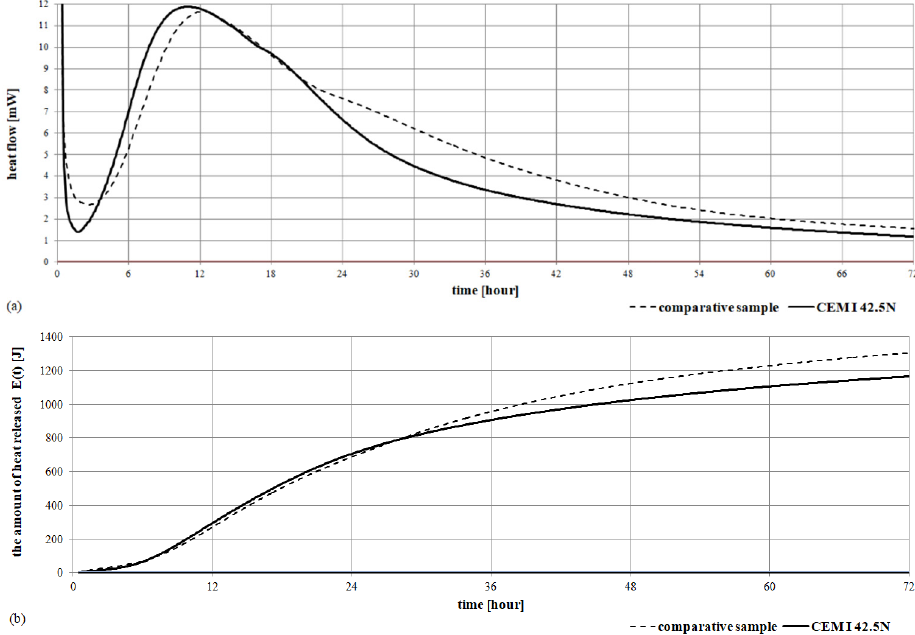
Figure 3. Cement characteristics: ( a ) isothermal calorimetry, ( b ) total heat evolution curves, and ( c ) cement diffraction pattern. 3.2. Materials: Ceramic Dust Ceramic dust included crystalline components: quartz, mullite, cristobalite, corundum, very small amounts of clay minerals, and anorthite. [81] The characteristics of the ceramic dust are presented in Figure 4. Figure 4. The ceramic dust intended for the laboratory tests: ( a ) natural sample, ( b , c ) sample observed in SEM, ( d ) diffractogram of the sample composition. Based on the results obtained from the thermal analysis of the ceramic dust used (Figure 5), it was found that in the case of dust with grain size 0/1 mm (a) in the temperature range of 20–150 °C and for dust with grain size 0/2 mm (b) in the temperature range of 20–185 °C, there is free and bound water in the relics of hydrated minerals clayey. Transformation of kaolinite to metakaolinite occurs in the temperature range of 300–567 °C (for dust with grain size 0/1 mm) and in the temperature range of 200–568 °C (for dust with grain size 0/2 mm). The decomposition of carbonate minerals occurs in the case of